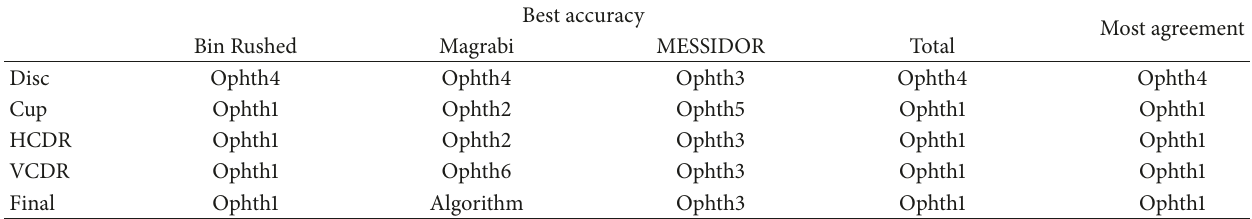
Table 17: The best accuracy and agreement for all the four parameters and the three images sets .